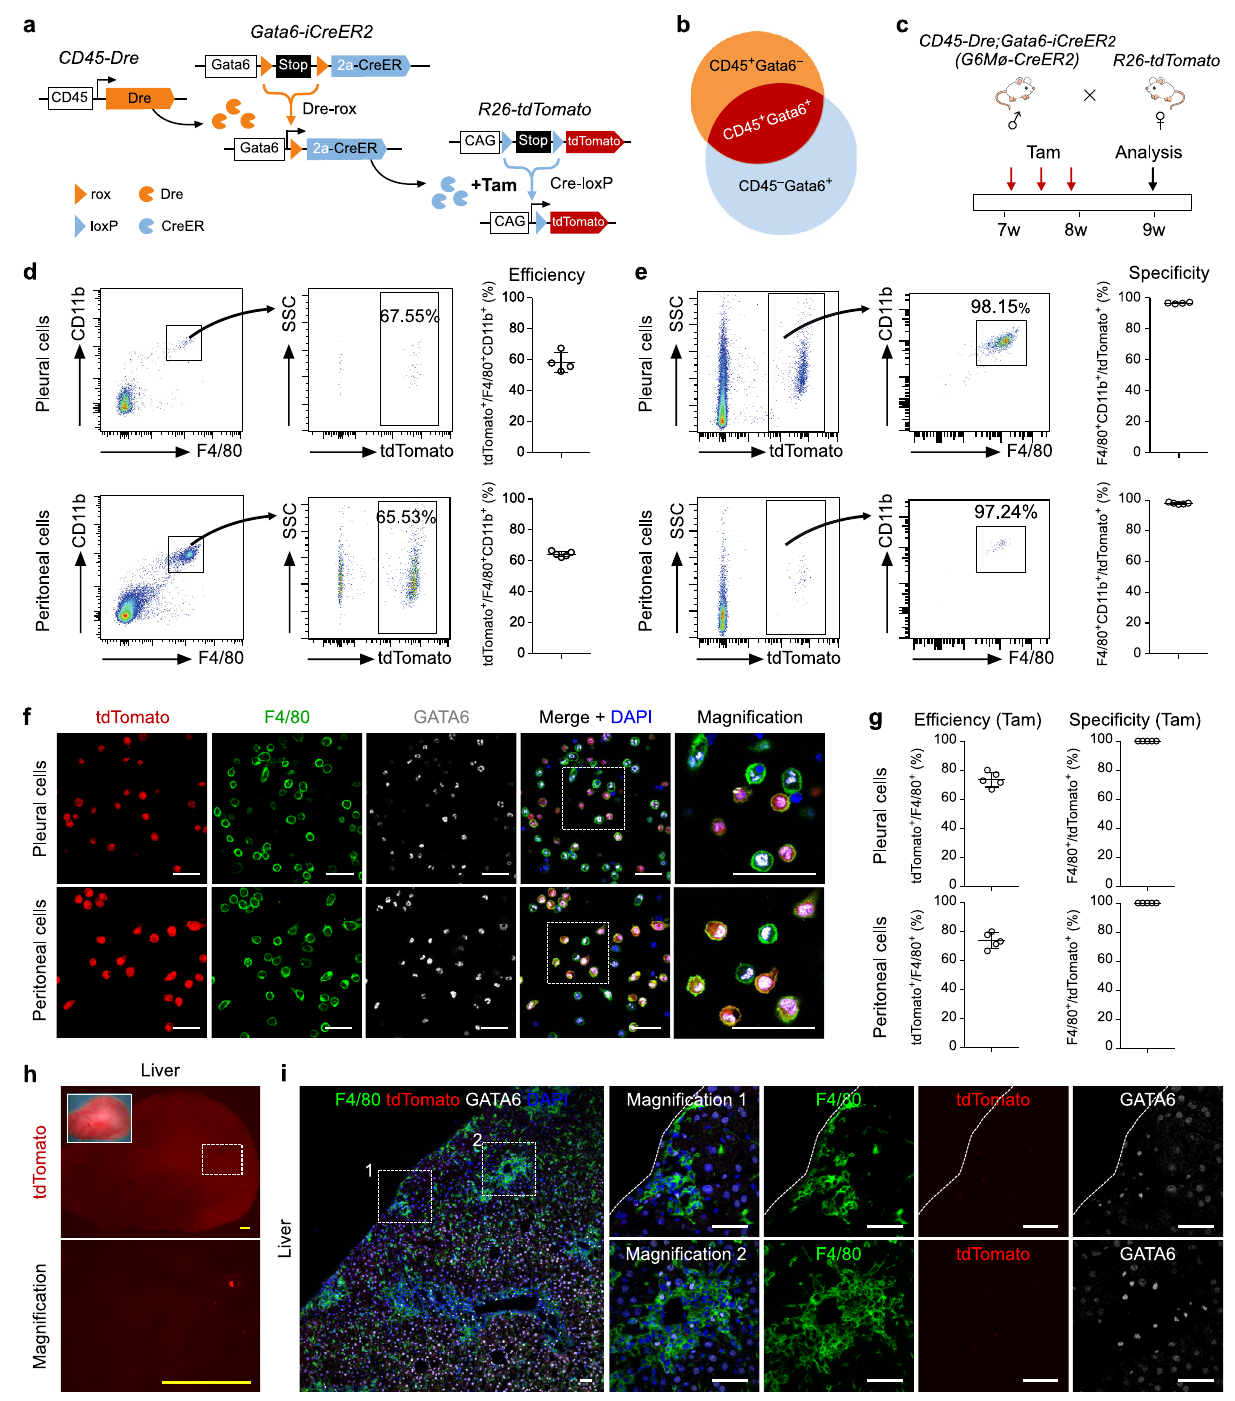
Fig. 6 Generation and characterization of Gata6-iCreER2 for fate mapping of cavity macrophages. a Schematic fi gure showing experimental strategy. Gata6-iCreER2 uses a knock-in strategy that maintains endogenous Gata6 gene expression. b Intersectional genetics marks CD45 + GATA6 + cells as tdTomato. c Schematic fi gure showing experimental design using a second cavity macrophage CreER line ( G6Mø-CreER2 ). d , e Flow cytometric analysis of the percentage of tdTomato + cells in macrophages from the pleural and peritoneal cavity (left panel); and the percentage of F4/80 + macrophages in tdTomato + cells from the pleural and peritoneal cavity (right panel). For pleural cells, data are the mean ± SD; n = 4 mice per group. For peritoneal cells, data are the mean ± SD; n = 5 mice per group. f Immunostaining for tdTomato, GATA6, and F4/80 on dissociated cells from the pleural or peritoneal cavity. Boxed regions are magni fi ed. g Quanti fi cation of the percentage of F4/80 + macrophages expressing tdTomato, or the percentage of tdTomato + cells expressing F4/80. Data are the mean ± SD; n = 5 mice per group. h Whole-mount epi fl uorescence images of the liver after CCl 4 injury. The boxed region is magni fi ed. i Immunostaining for tdTomato, GATA6, and F4/80 on the injured region of livers. Dotted lines indicate the surface of tissue sections. Boxed regions are magni fi ed. Each image is representative of fi ve individual biological samples ( f , h , i ). Scale bars, yellow, 1 mm; white, 100 µ m. Source data are provided as a Source Data fi